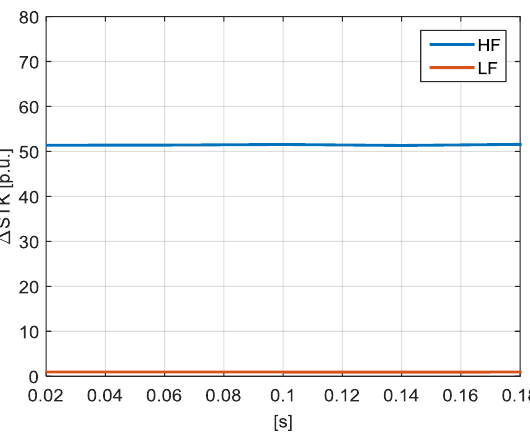
Figure 33. Case study 2: Δ STK at low-frequency (0 ÷ 2 kHz, red line) and at high-frequency (2 ÷ 150 kHz, blue line) obtained through STFT.